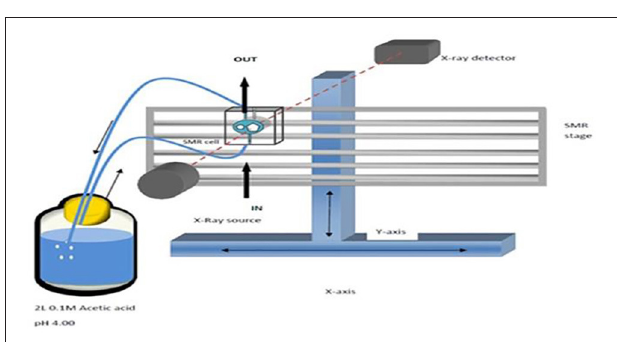
FIGURE 1 | Schematic diagram of SMR experimental set up showing X-rays parallel to the direction of acid attack and perpendicular to the enamel